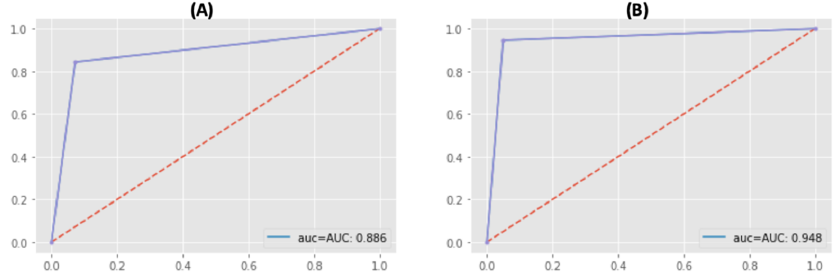
Figure 7 . Accuracy Result (ROCAUC): ( A ) 120-day model’s accuracy is 88.6%, ( B ) 360-day model’s accuracy is 94.8% . Table 2. Determining epochs to build model.